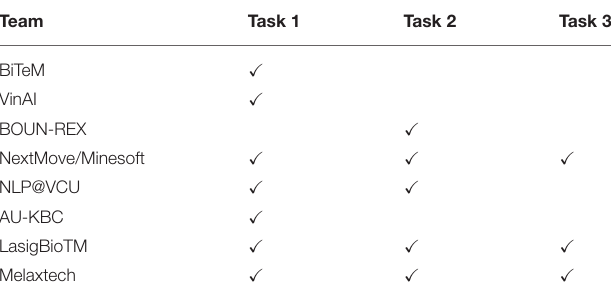
TABLE 10 | The task participation of the 8 teams BiTeM, VinAI, BOUN-REX, NextMove/Minesoft, NLP@VCU, AU-KBC, LasigBioTM, and